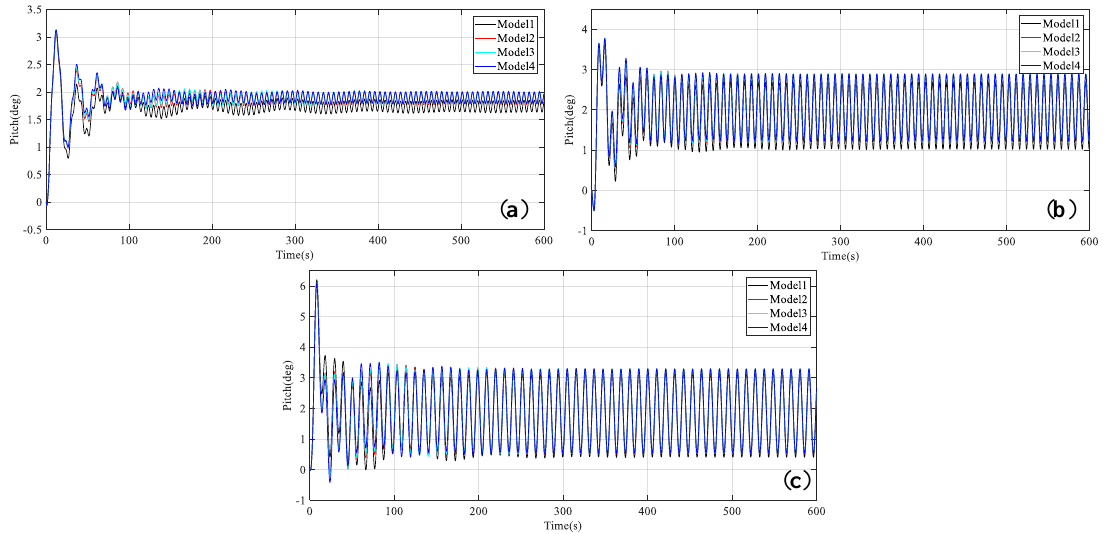
Figure 9. Time domain curves of the heave motion of Models 1~4: ( a ) LC1; ( b ) LC2; and ( c ) LC3.